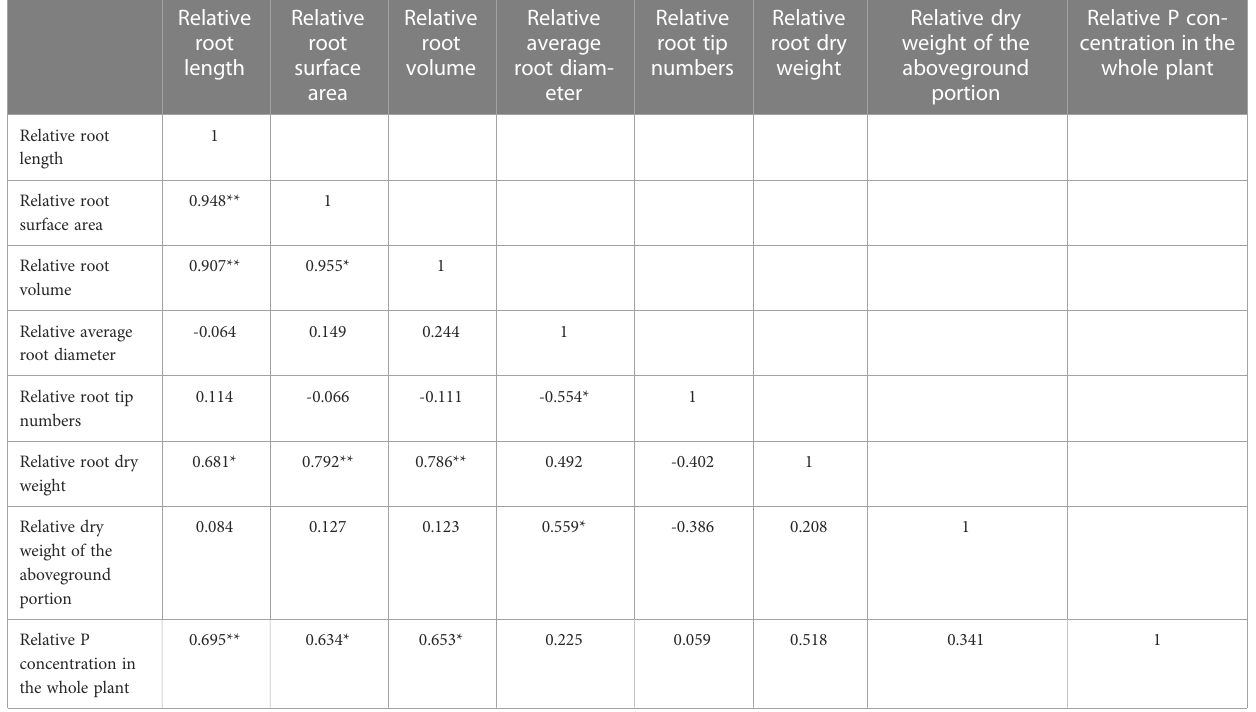
TABLE 1 Correlation analysis of root morphology and low-P